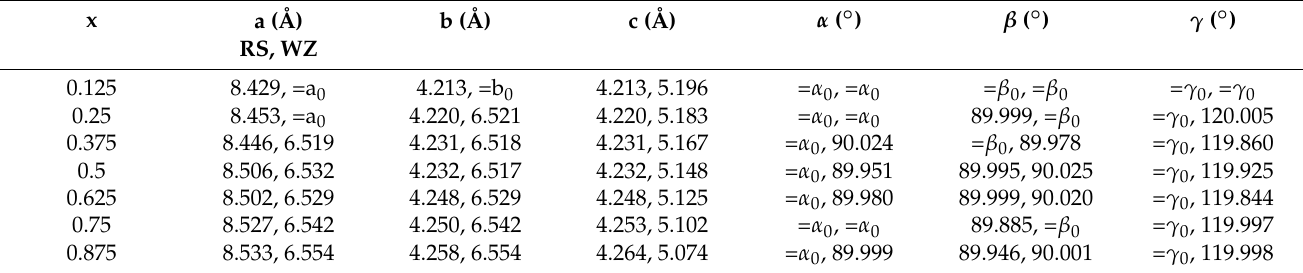
Table 1. Equilibrium lattice parameters of 2 × 1 × 1 rocksalt (RS) Mg 1 − x Zn x O and 2 × 2 × 1 wurtzite (WZ) Zn 1 − x Mg x O at different concentrations of substituted